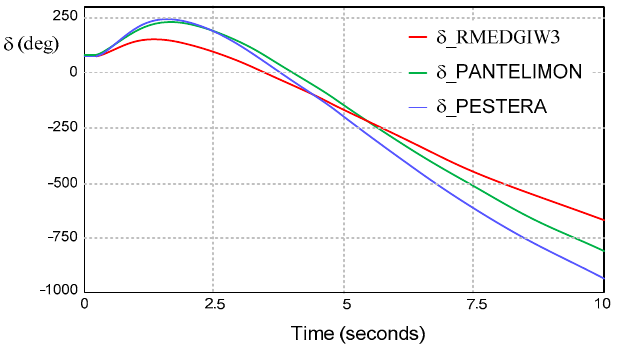
Figure 13. Internal angles of asynchronous wind power generators in case of short-circuit on a 110 kV line.